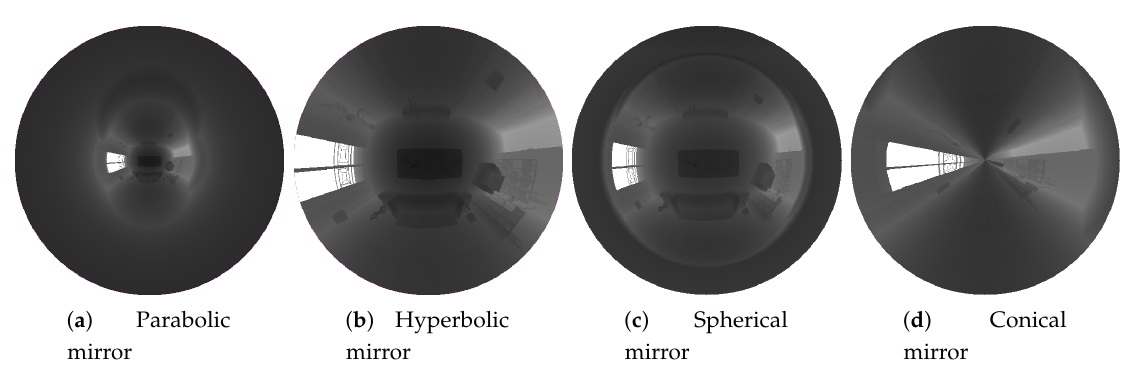
Figure A8. Semantic mode.